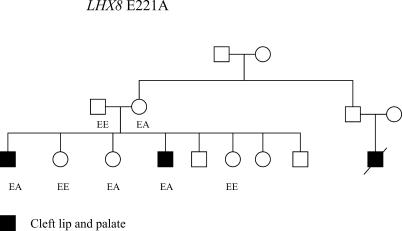
Family Pedigree of the Filipino Proband with the LHX8 E221A MutationThe segregation pattern of the mutation is not consistent with a simple Mendelian model for the disease.EE (glutamic acid–glutamic acid) indicates the wild-type genotype. EA (glutamic acid–alanine) indicates the genotype of the individuals carrying the mutation.